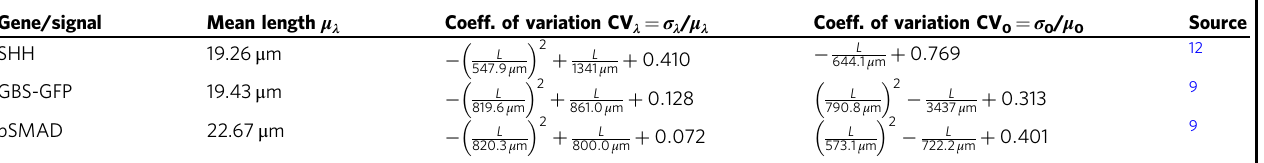
Table 1 Fitted statistical gradient parameters for the mouse neural tube.